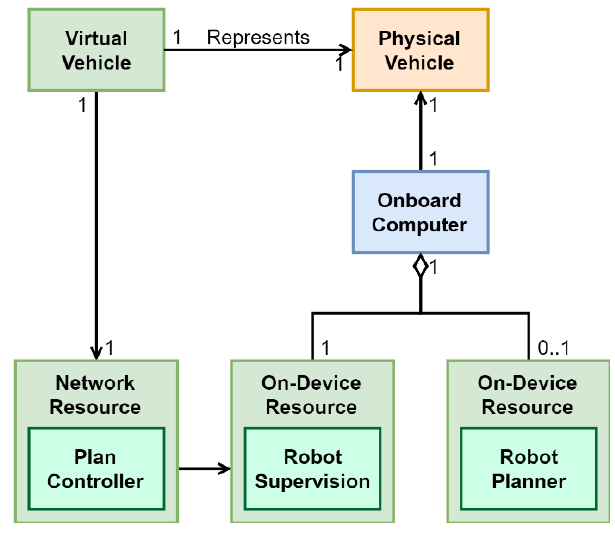
Figure 8. Overview of the vehicle virtualization used at the MTRR.